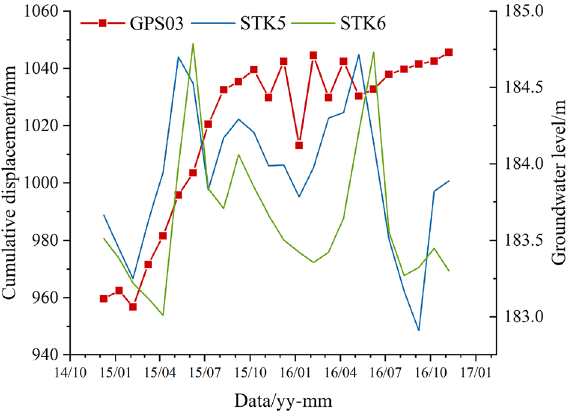
Figure 7. Monitoring data comparison of GPS03, STK5, and STK6.